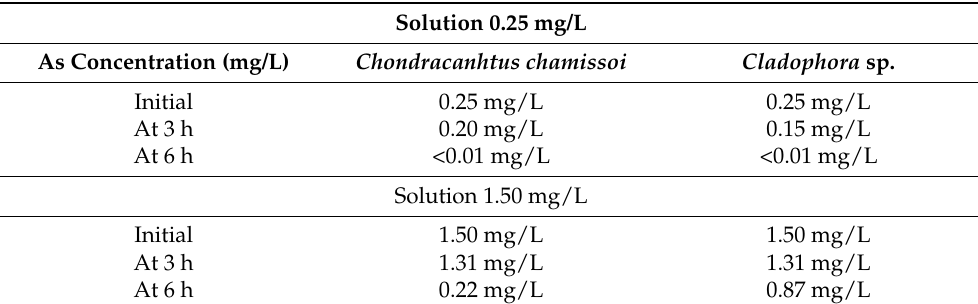
Table 1. Arsenic concentrations at the beginning and after 3 and 6 h of treatment with Chondracanthus chamissoi and Cladophora sp, from As solutions of 0.25 and 1.50